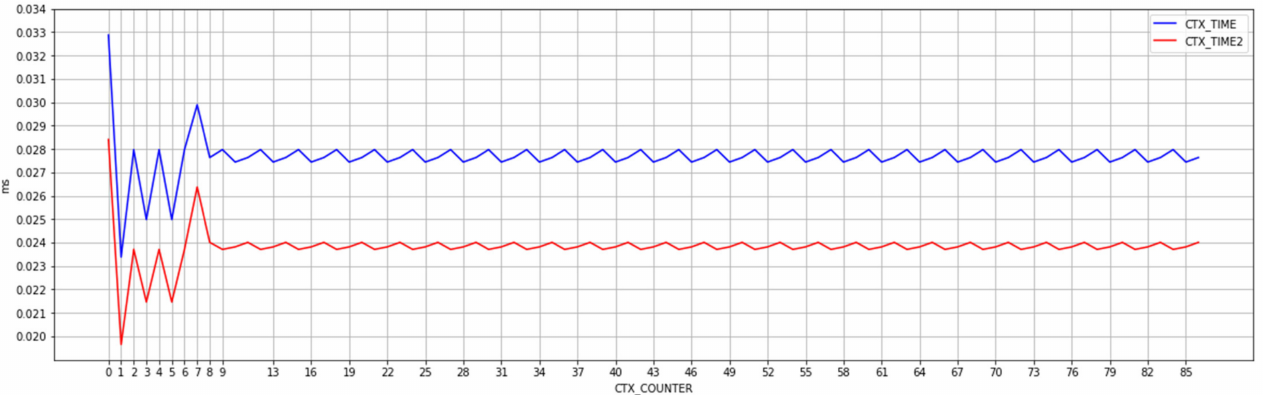
Figure 7. Context switching